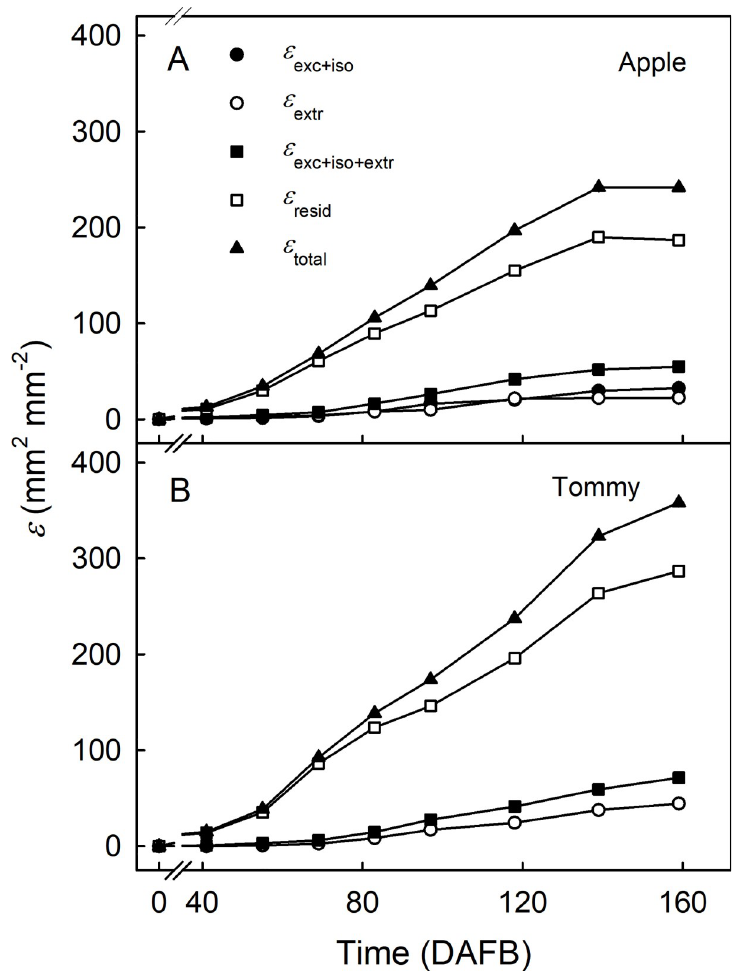
Fig 8. Developmental time course of change in total cumulative strain ( ε total ), strain released upon excision and isolation of the cuticular membrane (CM) ( ε ), that released after the extraction of wax ( ε ), the sum of the two exc + iso extr strains (due to wax and tissue) ( ε exc + iso + extr ), and the remaining strain ( ε resid ) of the skin of developing ‘Apple’ (A) and ‘Tommy Atkins’ (B) mango. The total cumulative strain of the CM ( ε ) was estimated from the increase in surface total area with time. The x-axis scale is in days after full bloom (DAFB). Data represent means ± SE. The number of replicates was